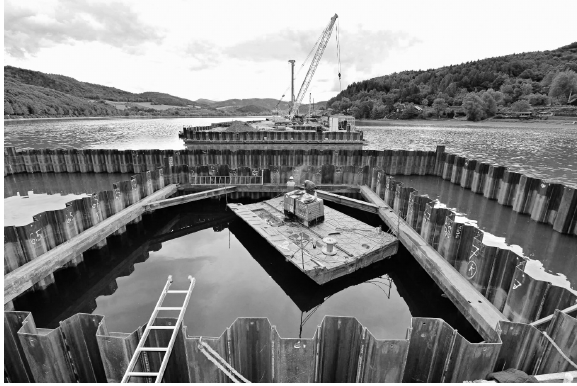
Figure 4. Mounting the spacer frame in the